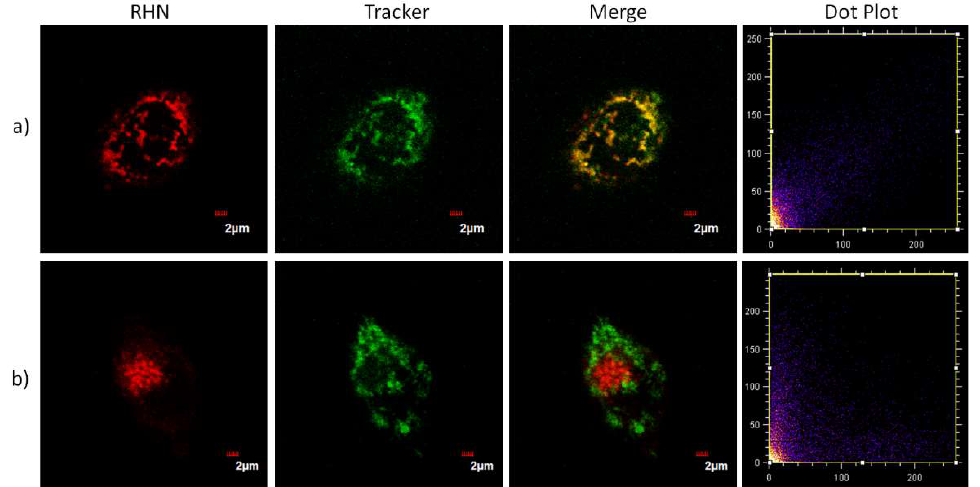
Figure 6. Imaging of HeLa cells costained with RHN (1 μM) upon treatment with MitoTracker ® Deep Red FM (200 nM) and LysoTracker ® Deep Red (200 nM). Cells were incubated with probes for 30 min, and then treated with OCl − (10 μM) for another 30 min. ( a ) Costained with MitoTracker ® Deep Red FM; ( b ) Costained with LysoTracker ® Deep Red. Green channel: λ ex = 488 nm; λ em = 510–600 nm; Red channel: λ ex = 559 nm; λ em = 647–671 nm.